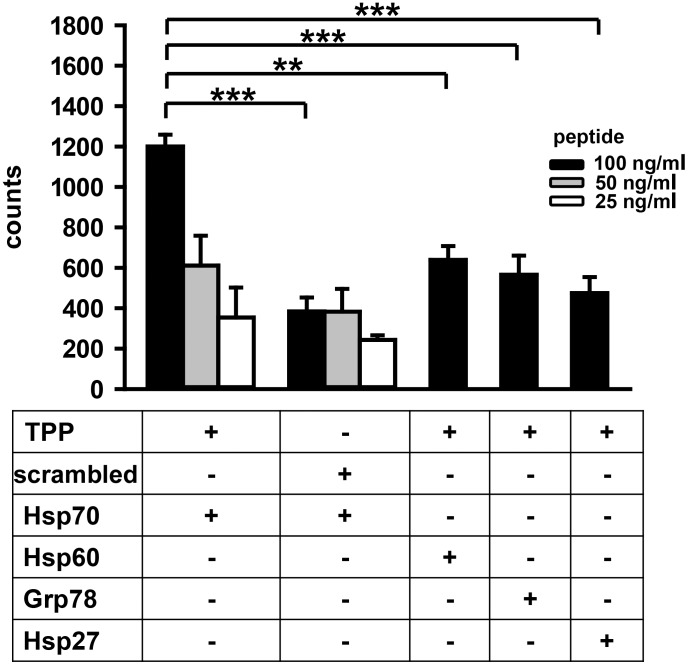
TPP specifically binds to Hsp70, but not to other Heat shock proteins (HSPs). A peptide ELISA was performed to determine the in vitro binding capacity of peptides to different HSPs. Ninety six well plates that were coated either with Hsp70, Hsp60, Grp78, or Hsp27 were incubated with carboxyfluorescein (CF)-labeled TPP or a scrambled peptide at concentrations ranging from 100 to 25 ng/ml. Fluorescence was measured after 30 min at 27°C using a multiplate reader. Combinations of peptides and proteins are indicated as “+” in the lower panel. Differences in peptide binding (100 ng/ml) were evaluated using the Student’s t-test (** p<0.01; *** p<0.001) (n = 3).